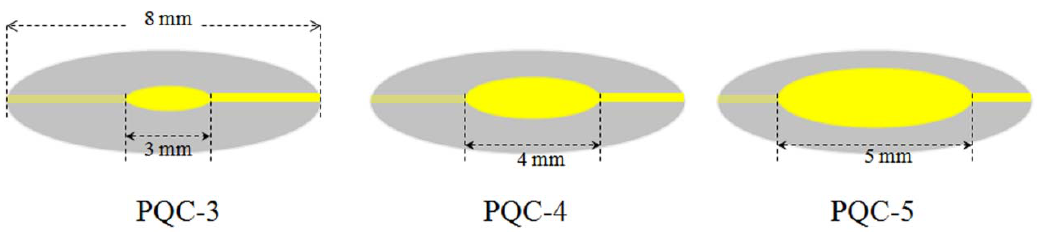
Figure 2. Illustration of the fabricated piezoelectric quartz crystal (PQCs) with three kinds of electrode diameters.